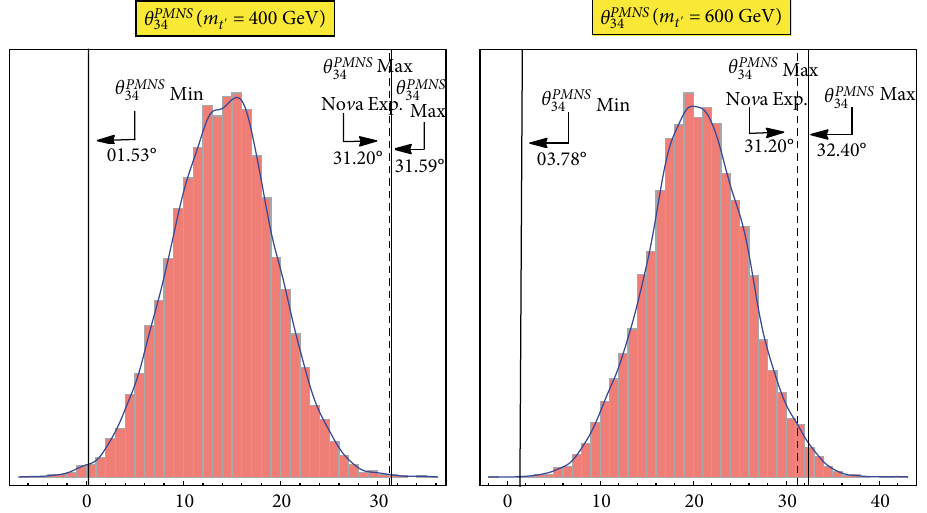
for 𝑚 = 400𝐺𝑒𝑉 (left) and 𝑚 24 𝑡 󸀠